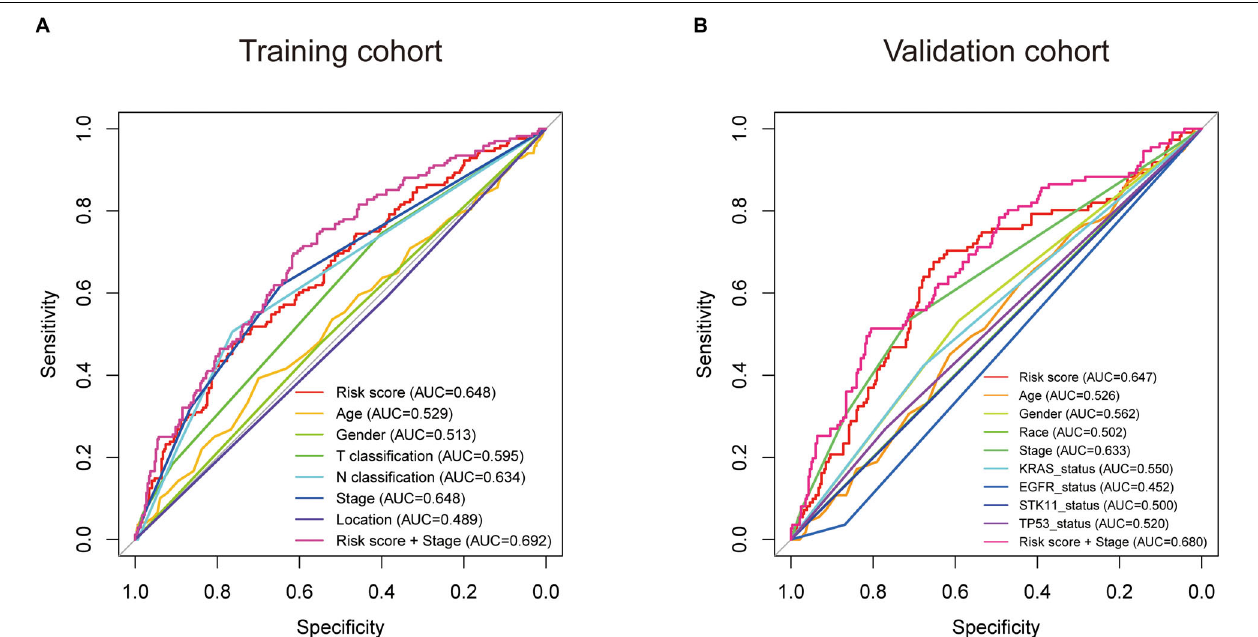
FIGURE 6 | Receiver operating characteristic (ROC) analysis of the eight-gene signature risk score. ROC analysis of the sensitivity and specificity of the prognosis prediction by the eight-gene risk score, age, gender, race, T classification, N classification, tumor stage, tumor location, KRAS status, EGFR status, STK11 status, TP53 status, or risk score + tumor stage in training cohort (A) and validation cohort (B) based on overall survival. AUC, area under the ROC